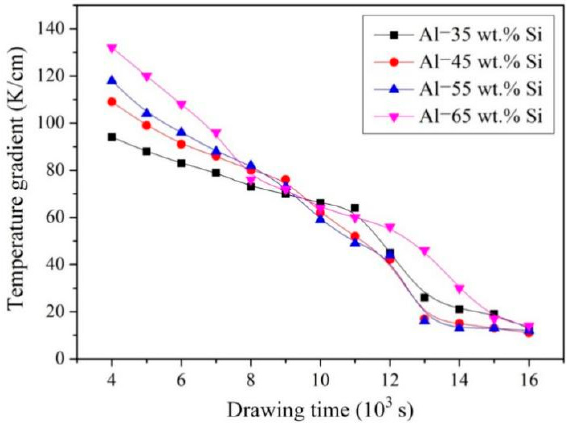
Figure 7. Temperature gradient variation as a function of drawing time.